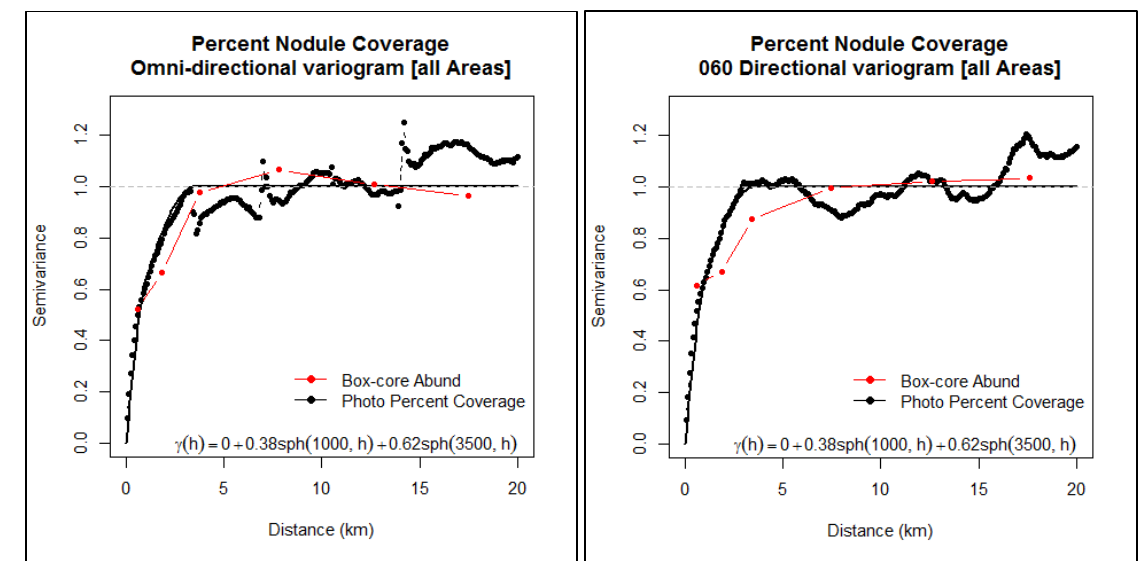
Figure 29. Omni-directional and 060° directional variograms for percent nodule coverage estimated from seafloor photos. Source: [12].